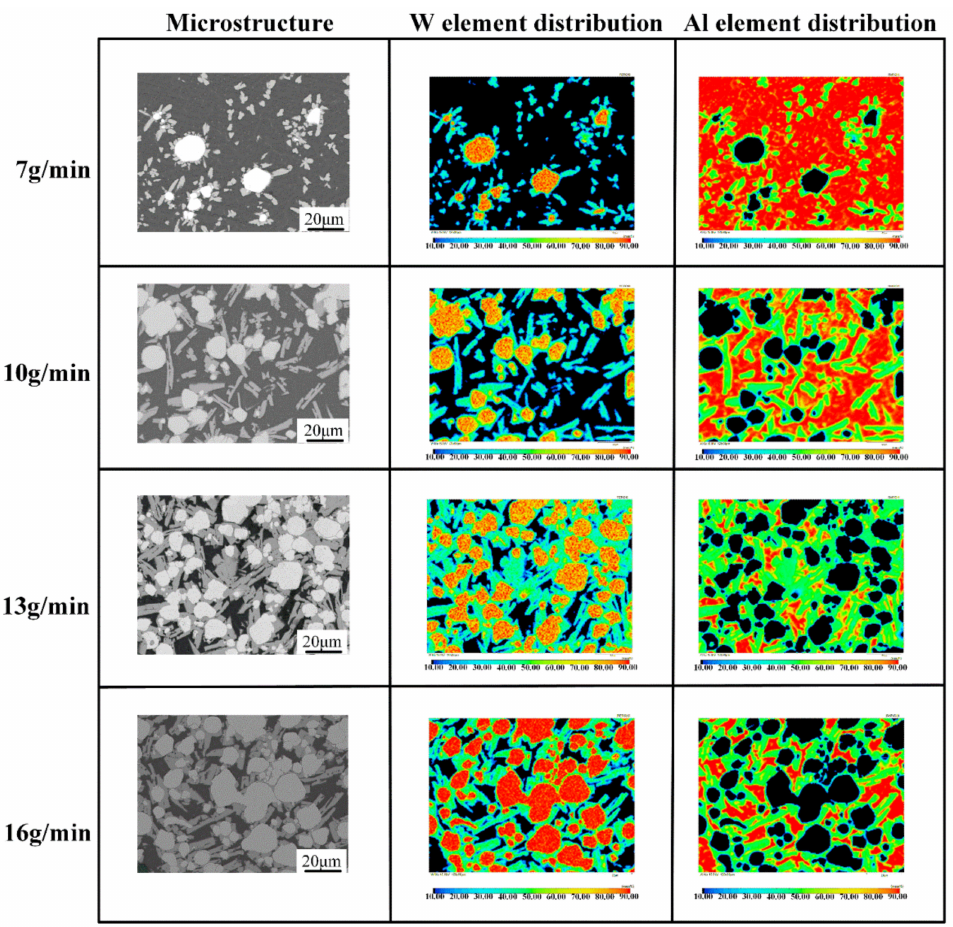
Figure 7. Microstructure and elemental distribution of the W/Al composite layers with powder feeding rates of 7 g/min, 10 g/min, 13 g/min, and 16